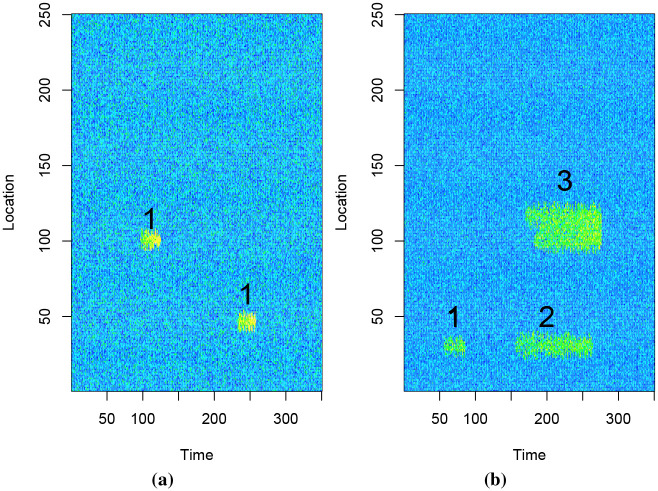
Class A events in Fig 5a and Class B events in Fig 5b.